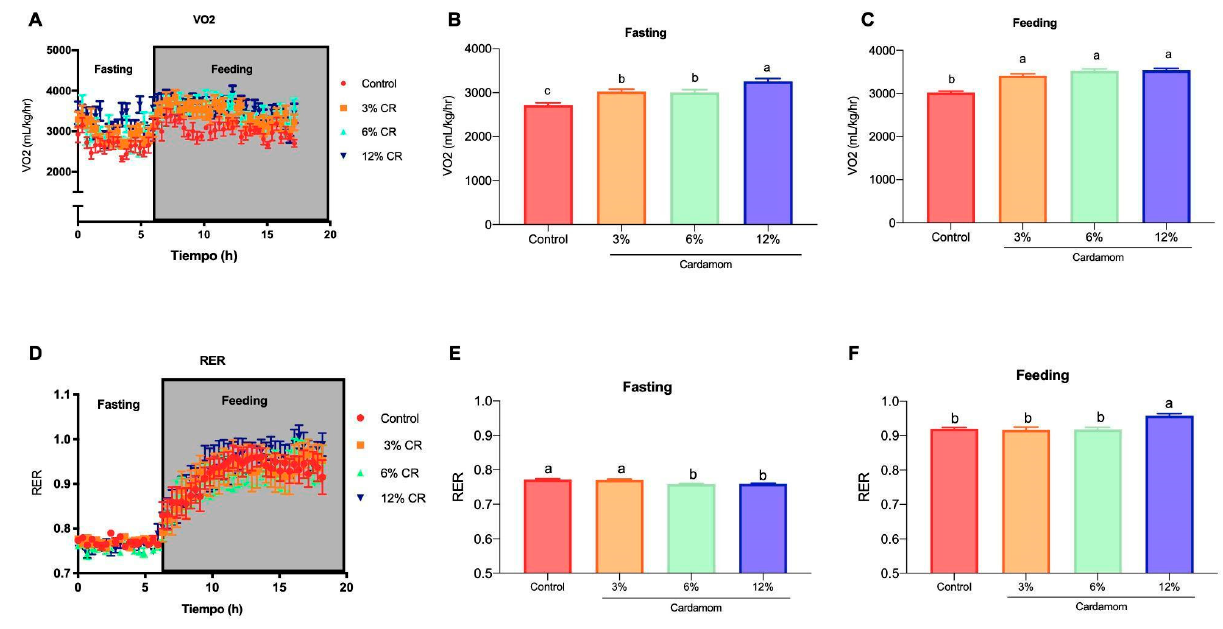
Figure 6. Energy expenditure and substrate oxidation of mice fed a control diet or a diet containing 3%, 6% or 12% of Elettaria cardamomum (EC). ( A ) Oxygen consumption (VO 2 ) during fasting and feeding periods determined by indirect calorimetry analysis; clear and shaded zones indicate fasting and feeding periods, respectively. Average oxygen consumption during ( B ) fasting and ( C ) feeding. ( D ) Respiratory exchange ratio (RER) and average RER during ( E ) fasting and ( F ) feeding periods of mice fed a control diet or a diet containing 3%, 6% or 12% EC. Data are presented as the mean ± S.E.M., n = 8 mice per group. The differences were considered statistically significant when p < 0.05. Mean values with different lowercase letters show statistical differences between each other.